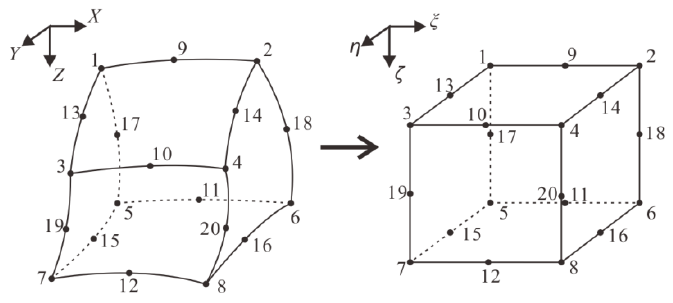
Figure 1. Domain transformation of a 20-node curved hexahedron. Table 1. Node coordinates in the computational domain.